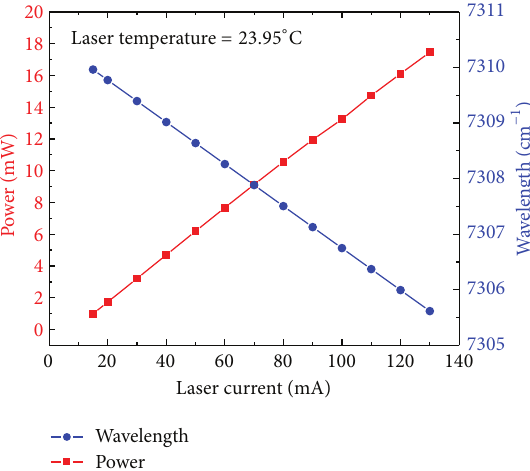
Figure 2: Output power and wavelength of the laser as a function of